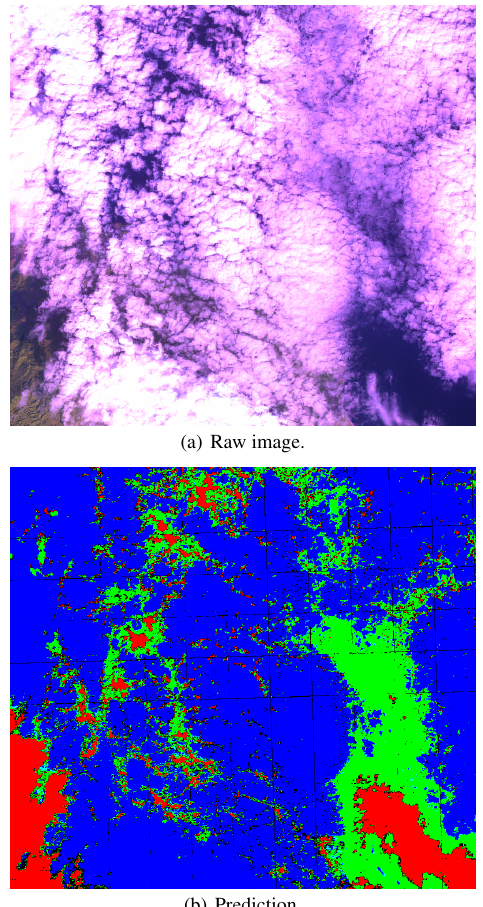
Figure 11. Merged prediction error.